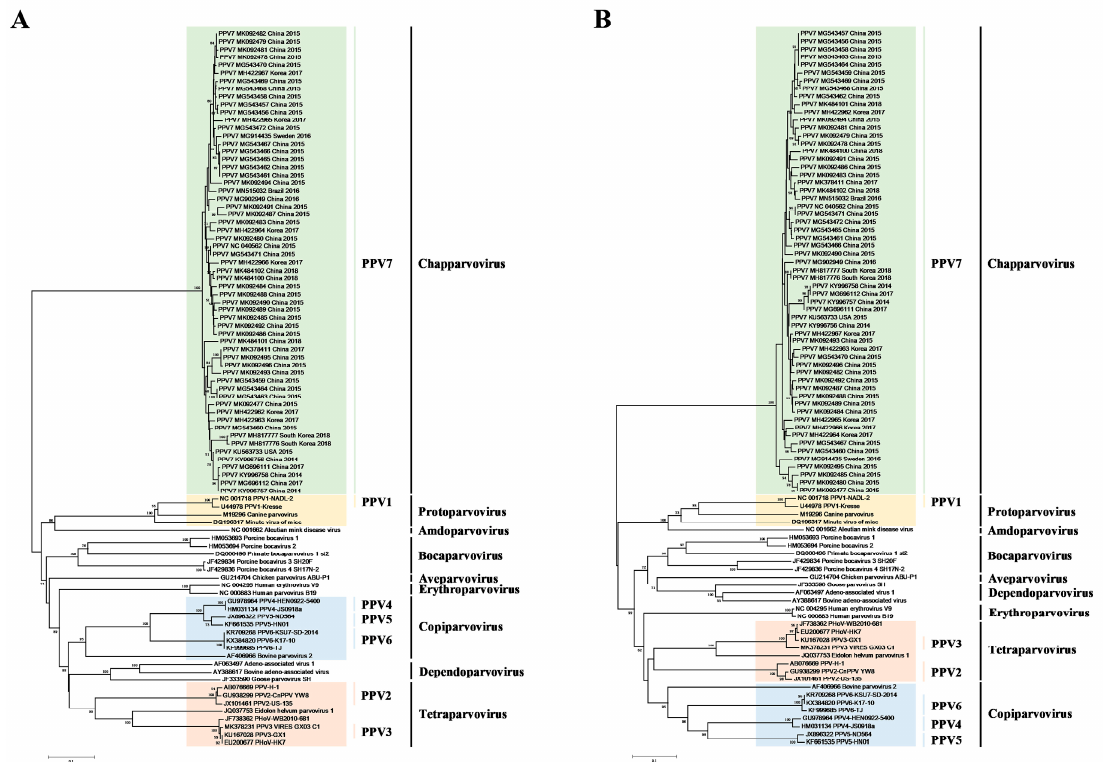
Figure 1. Phylogenetic analysis of viruses in the Parvoviridae family. Trees were constructed based on the NS1 ( A ) and Cap ( B ) amino acid sequences by the neighbor joining (NJ) phylogenetic method, using the p-distance model with 1000 bootstrap replicates and bootstrap > 50%.